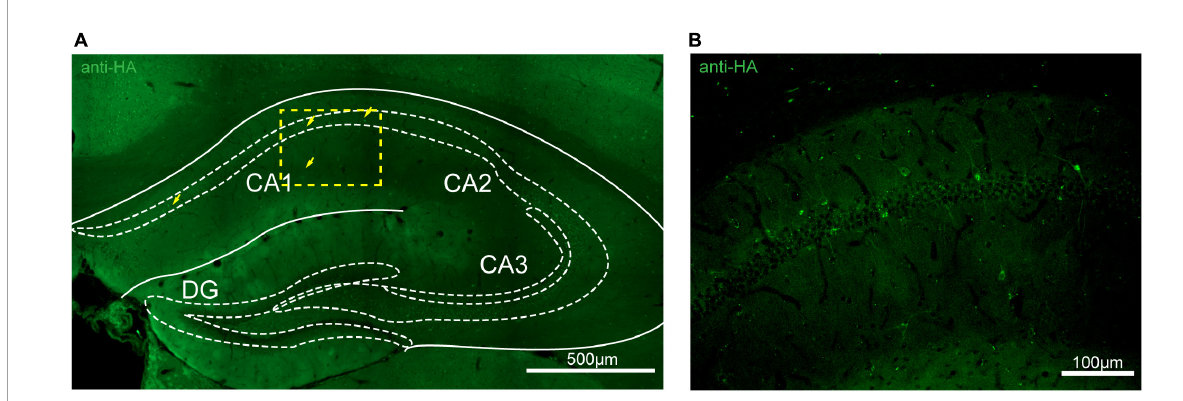
regulating myelinated axon excitability (Lezmy et al., 2021), it